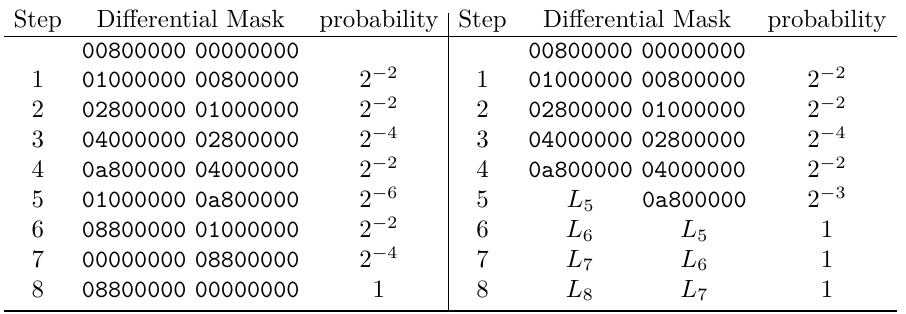
Table 3: Differential Propagation for 8-Round